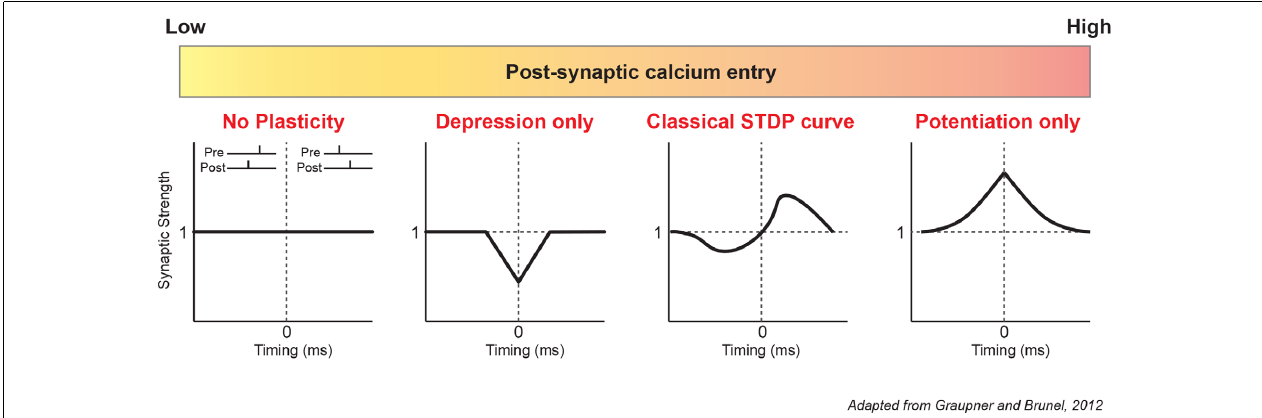
FIGURE 1 | Diversity of modeled STDP curves based on calcium. According to the modeling of Graupner and Brunel (2012), post-synaptic calcium is a major determinant of plasticity. From left to right: low calcium entry causes no plasticity or only depression ( t-LTD ). Intermediate calcium entry produces the classic STDP curve ( Hebbian STDP ), with a depression window ( t-LTD) for negative delays and a potentiation window ( t-LTP ) for positive delays. High calcium entry results in only potentiation for all delays. Note that these results were obtained with a simple 1:1 protocol (1 presynaptic, 1 postsynaptic stimulation) with a low pairing frequency of 1 Hz and 60 repetitions. STDP, Spike Timing-Dependent Plasticity.